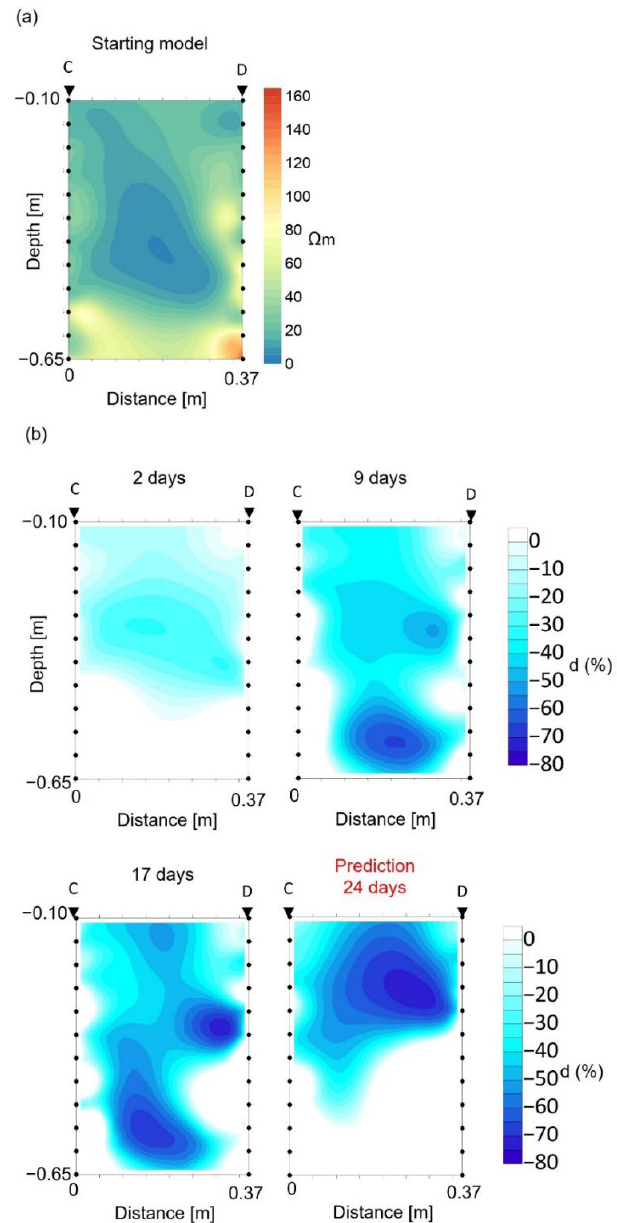
Figure 9. ( a ) True resistivity model obtained using ResIPy software of pre contamination condition; ( b ) images of resistivity variation (d, %) after salt solution injection. Black dots are electrodes, C and D are piezometers.